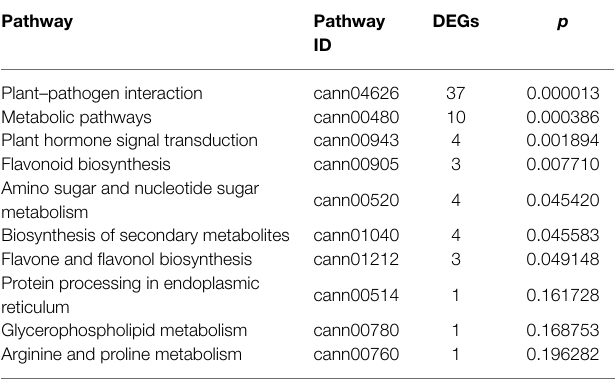
TABLE 3 | Top 10 Kyoto Encyclopedia of Genes and Genomes (KEGG) pathways enriched with upregulated DEGs when infected with BBWV2-PAP1.